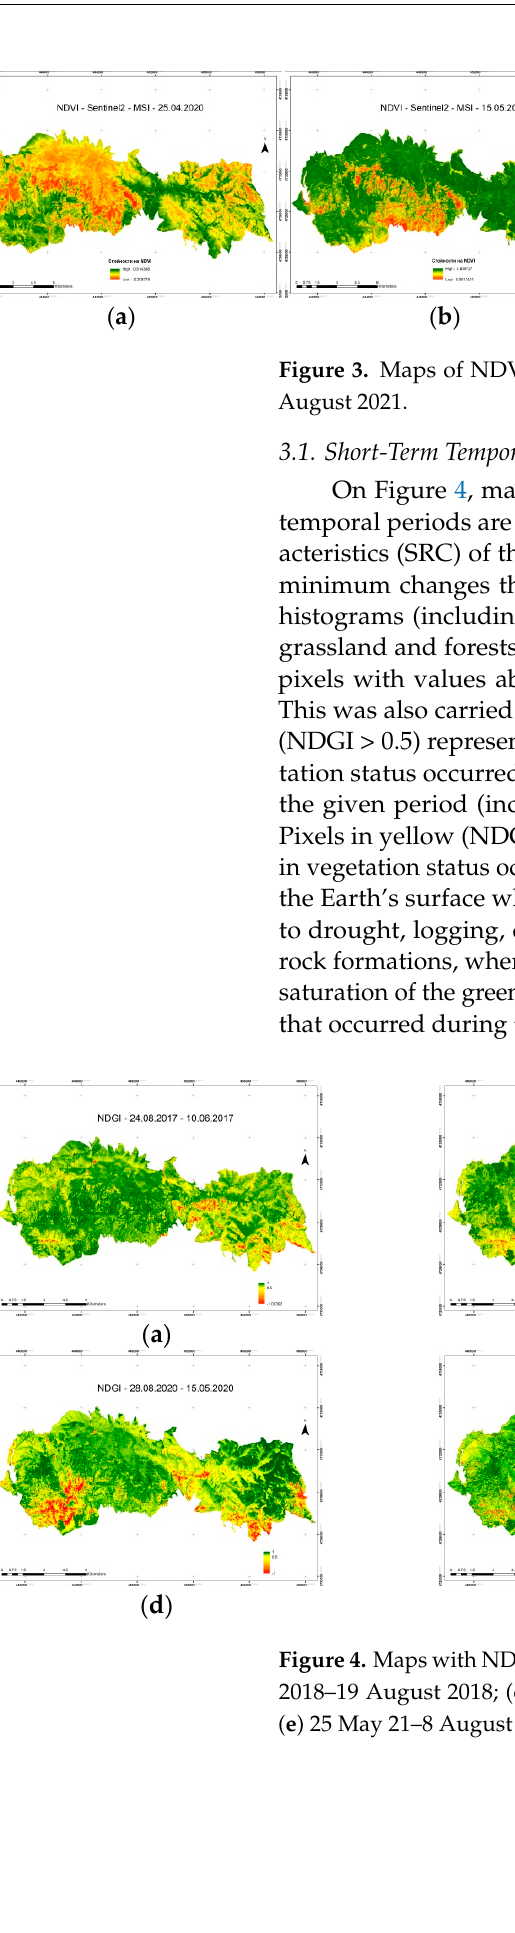
( d ) Figure 2. Maps of the TCT– greenness component values from: ( a ) 25 April 2020; ( b ) 15 May 2020; ( c ) 25 May 2021; ( d ) 08 August 2021.